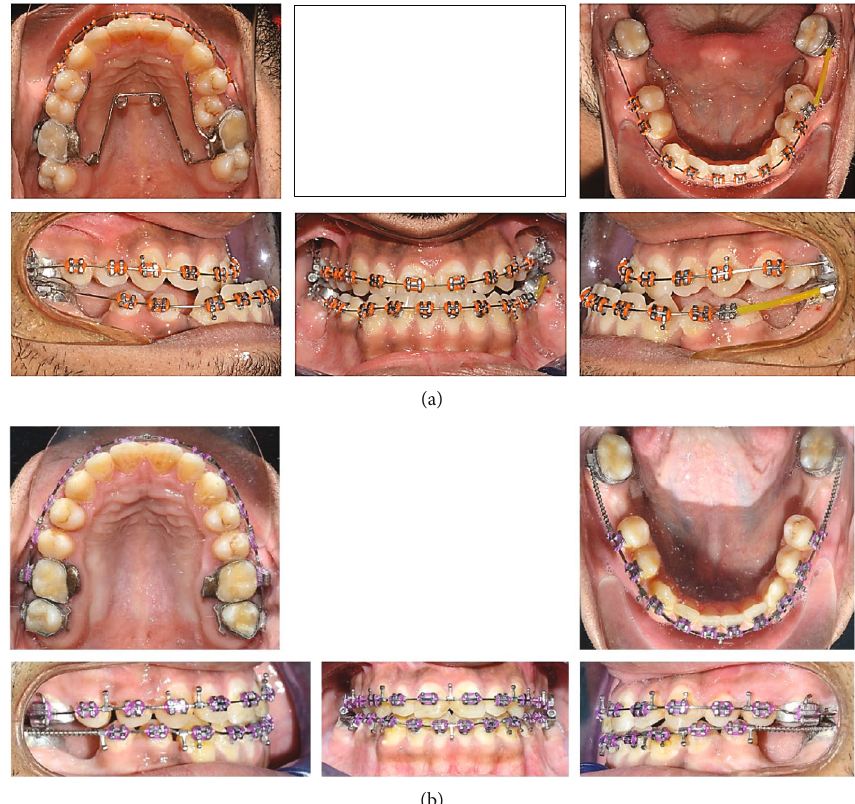
Figure 2: (a, b) Multiple progress